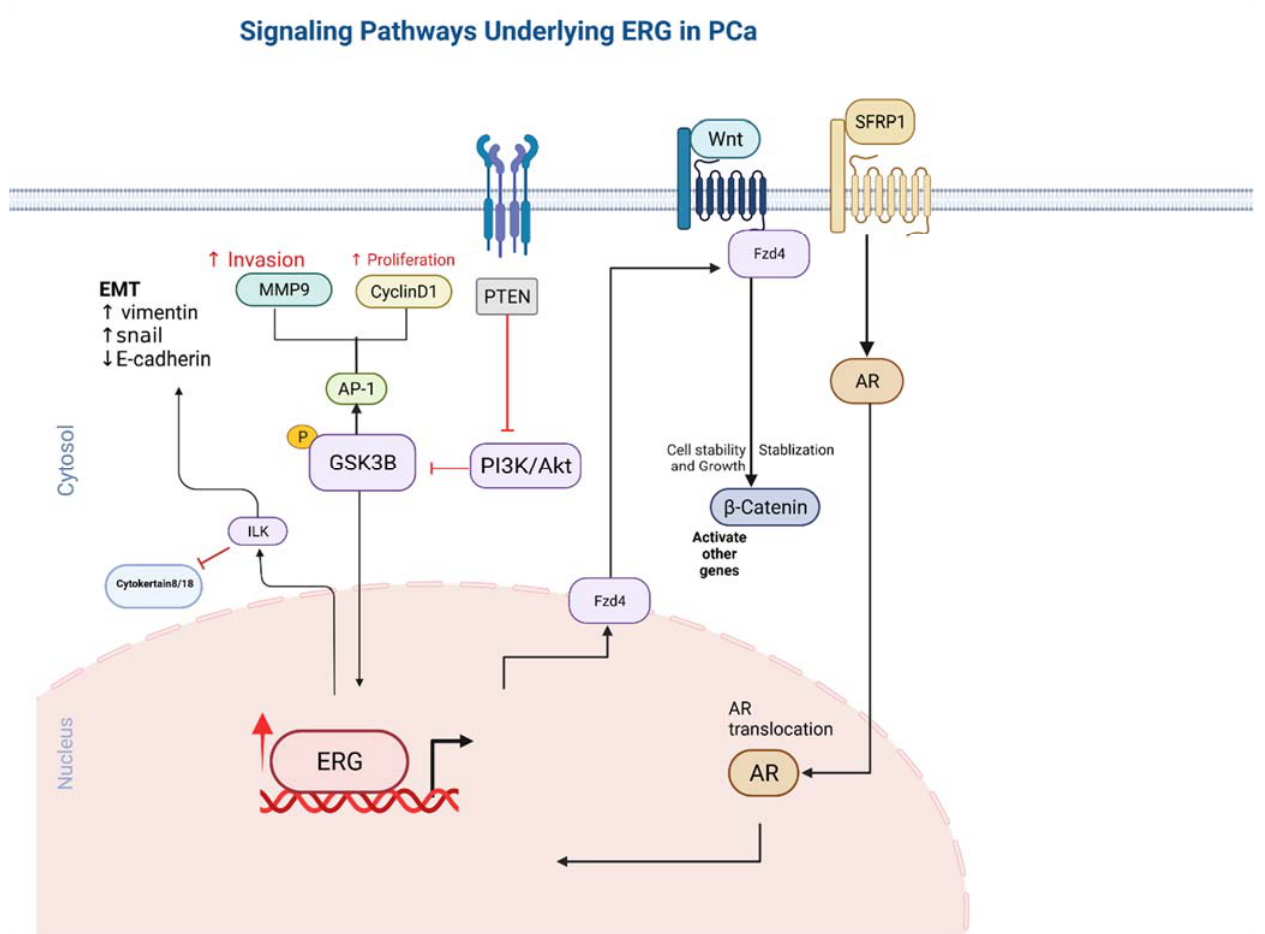
Figure 2. The pathways involved in ERG overexpression and related outcomes in tumor cells. Directional arrows indicate activation.